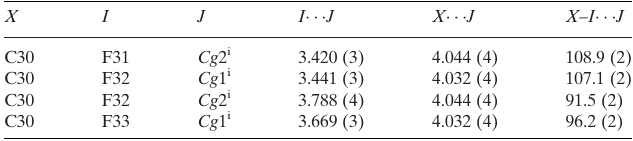
C–F (cid:2)(cid:2)(cid:2) (cid:3) interactions (A˚ , (cid:4) ). Cg 1 and Cg 2 are the centroids of the C9/N10/C11–C14 and C1–C4/C11/C12 rings, respectively. X